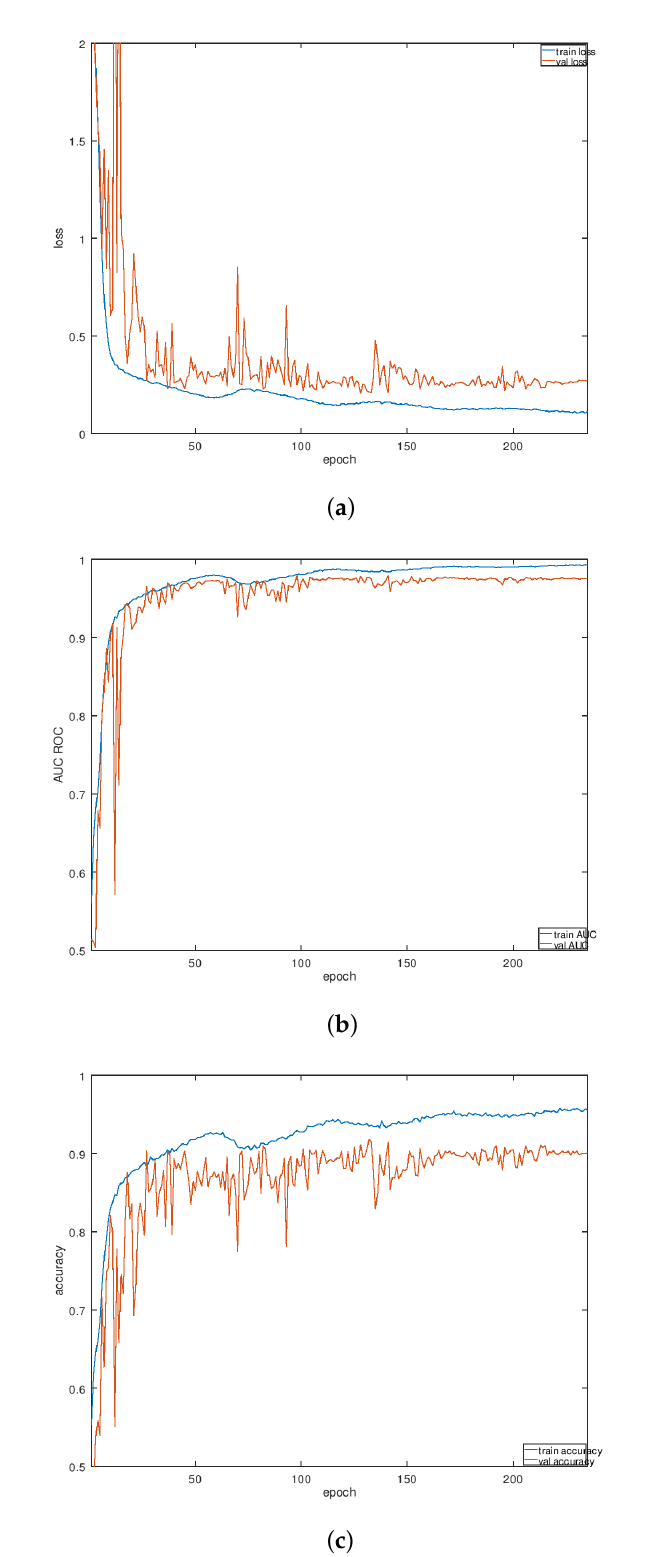
Figure 9. Training performance: ( a ) loss; ( b ) ROC AUC; ( c )